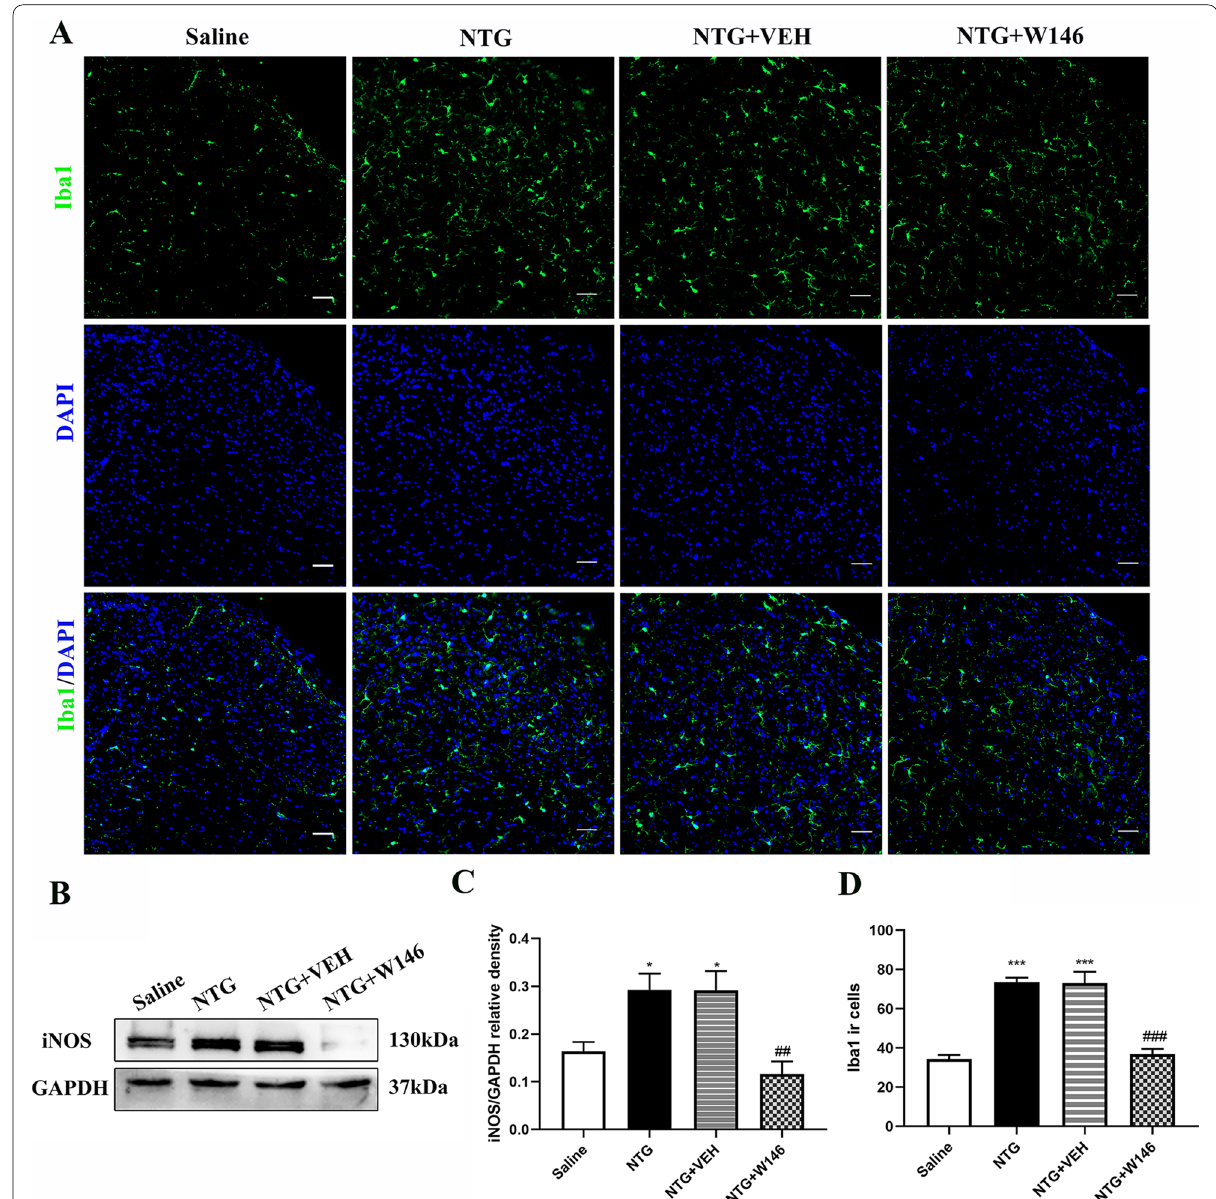
Fig. 4 Blocking S1PR1 signaling suppressed NTG-induced microglia activation in the TCC area . A Representative immunofluorescence images of Iba1 in the TCC for the Saline, NTG, NTG VEH and NTG W146 group under an 10 objective lens. B‑C Western blots showed the changes in + + × iNOS protein levels among the Saline, NTG, NTG VEH and NTG W146 group. These results indicated daily administration of W146 decreased + + the expression of iNOS. n 6 per group; * p < 0.05 compared with the Saline group; ### p < 0.001 compared with the NTG group. D Quantification = of Iba1-positive cells. These results indicated daily administration of W146 decreased Iba1 ir cells. n 3 per group; *** p < 0.001 compared with the = Saline group; ### p < 0.001 for the NTG W146 group compared with the NTG +